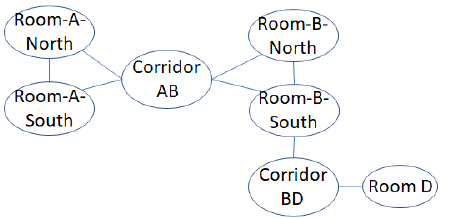
Figure 4. Semantic graph of the floor plan in Figure